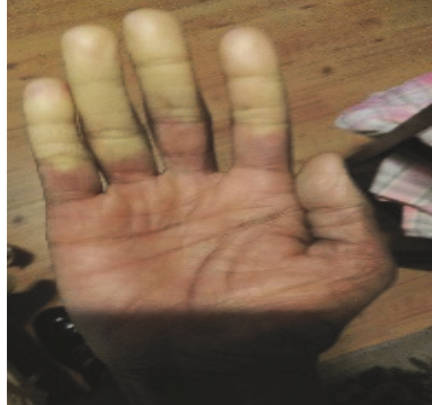
Figure 4: Left brachial artery with a short focal tapered occlusion, with likely dissection and collateral muscular